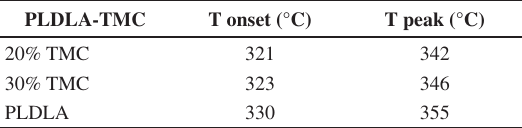
Table 6. Thermal properties of PLDLA-TMC obtained using 20% and 30% TMC and PLDLA.